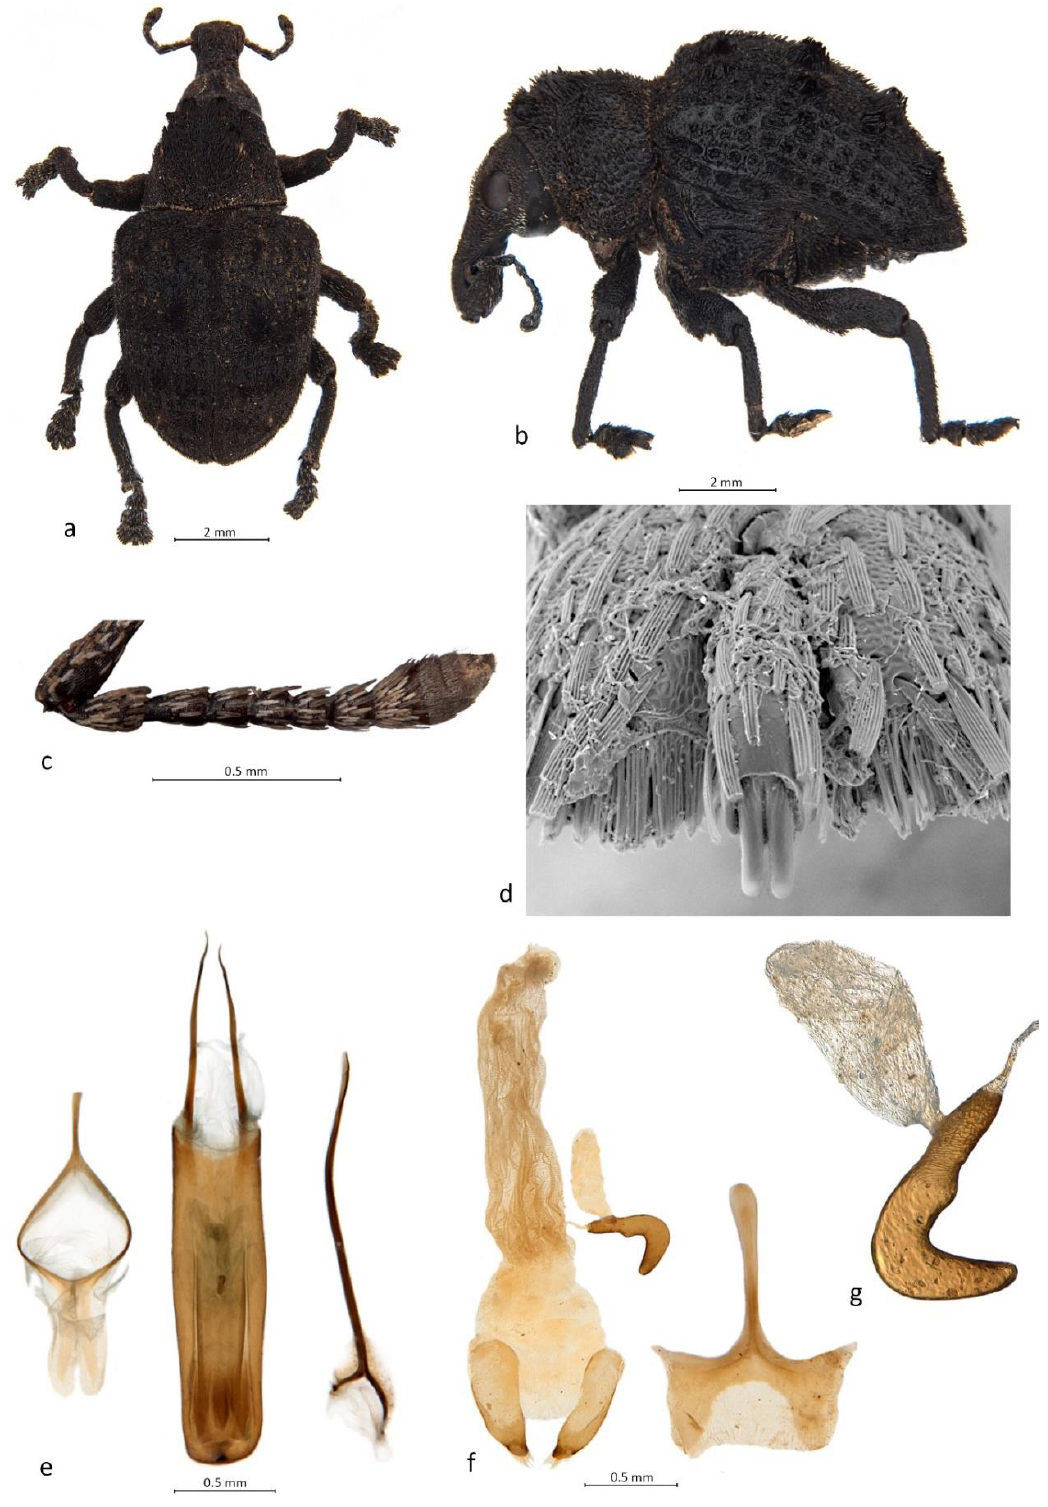
Figure 4. Habitus and diagnostic characters of Sigastus Pascoe ( S. fascicularis Pascoe): ( a ) habitus of male, dorsal view; ( b ) habitus of male, left lateral view; ( c ) right antenna, male, dorsal view; ( d ) tarsite 3 with onychium, apical view; ( e ) genitalia, male, dorsal view; ( f ) genitalia, female, dorsal view; ( g ) spermatheca with gland.